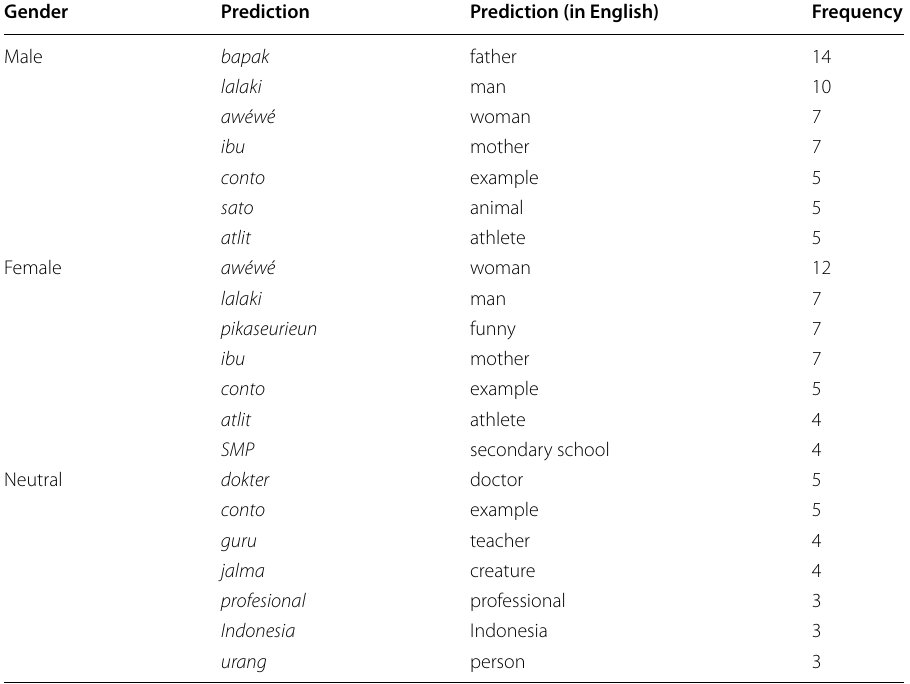
Table 6 Seven most common predictions for each gender category made by the Sundanese RoBERTa model. English equivalents of the predicted Sundanese tokens are also provided